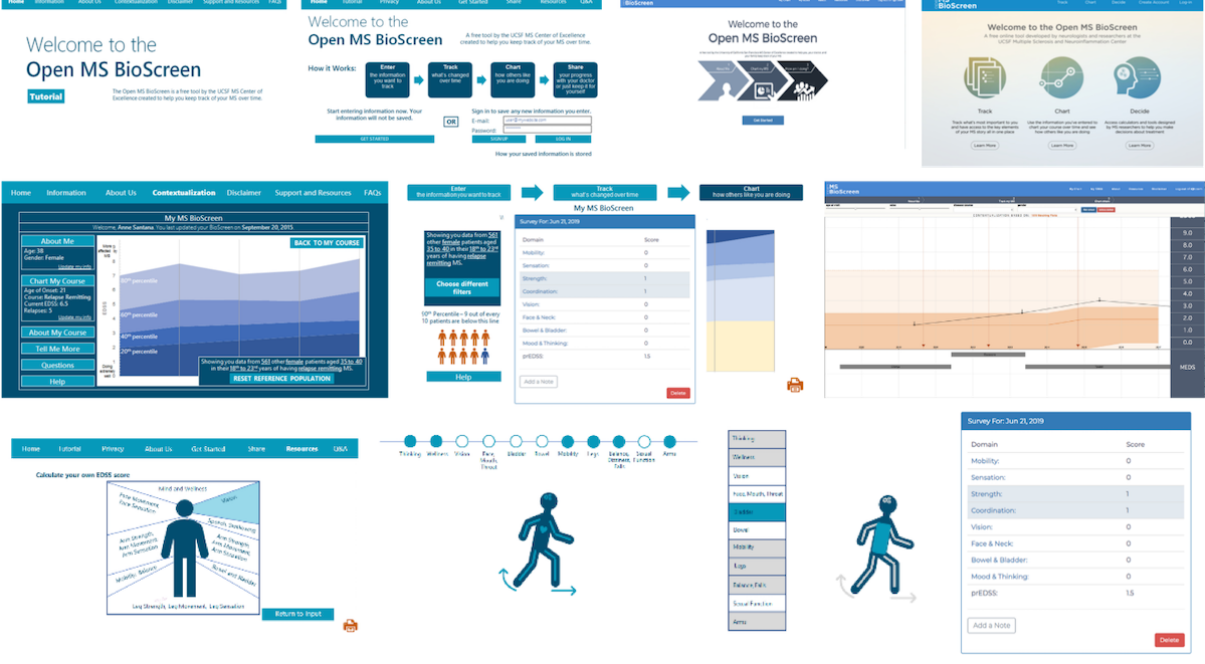
Figure 3. Phase II: Ideation. Evolution of Open MS BioScreen mock-ups. Top panel: landing page. Middle panel: longitudinal disease course visualization and contextualization tool. Bottom panel: assessment and representation of global neurological